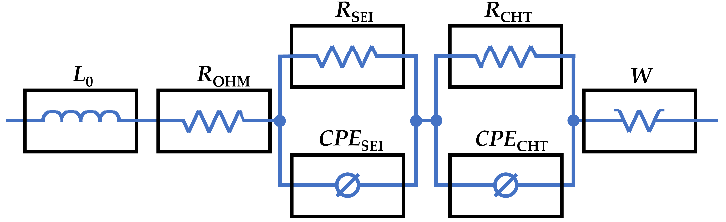
Figure 2. The equivalent electric circuit used for EIS data analysis in this study.